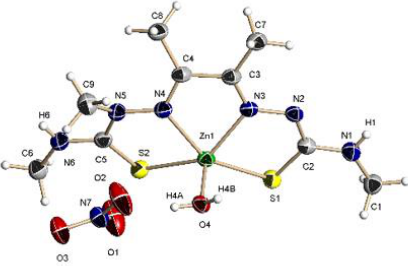
Figure 3. Molecular structure of 2. Thermal ellipsoids at 50% probability level.